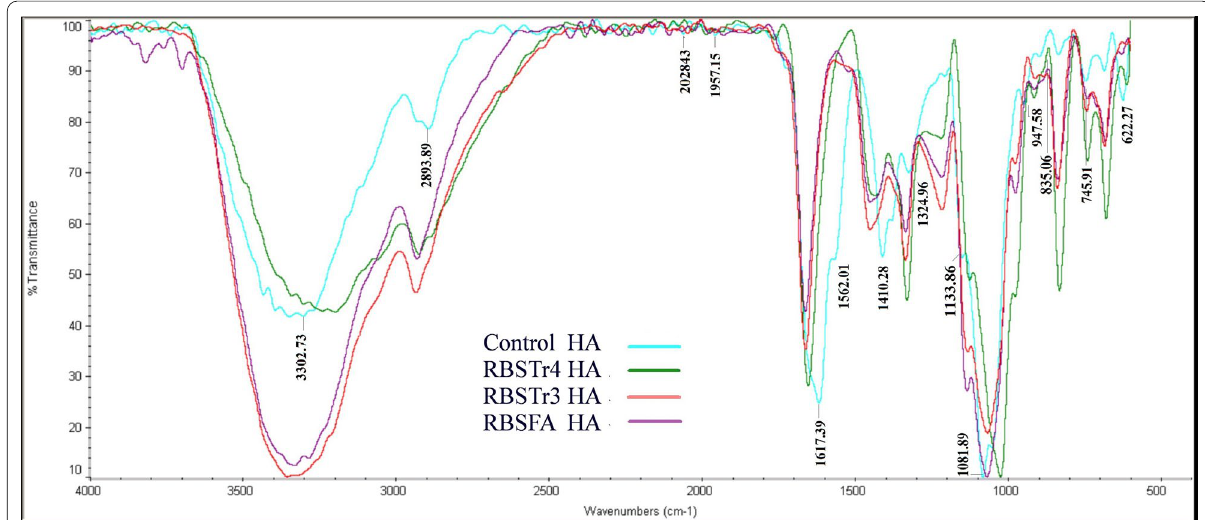
Fig. 4 FTIR characterization of purified HAs from RBSFA, RBSTr4, and RBSTr3 strains along with standard